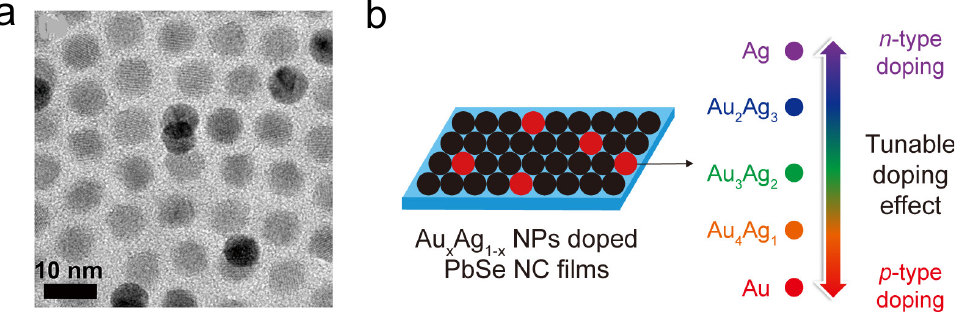
Figure 5. ( a ) TEM picture showing the dopants in the PbSe superlattice. ( b ) Illustration of Au x Ag 1 − x NP-doped PbSe superlattice film and the doping effect. Reprinted with permission from [76]. Copy- right 2018 American Chemical